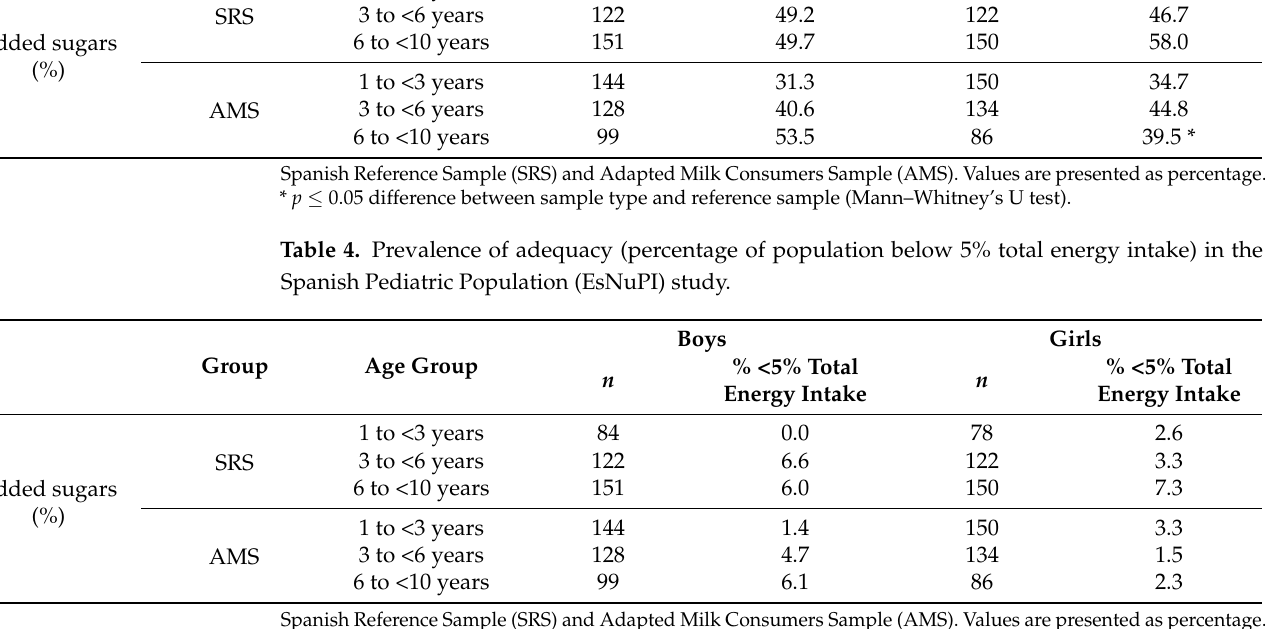
Table 5 details the intake of added sugars according to body composition, a